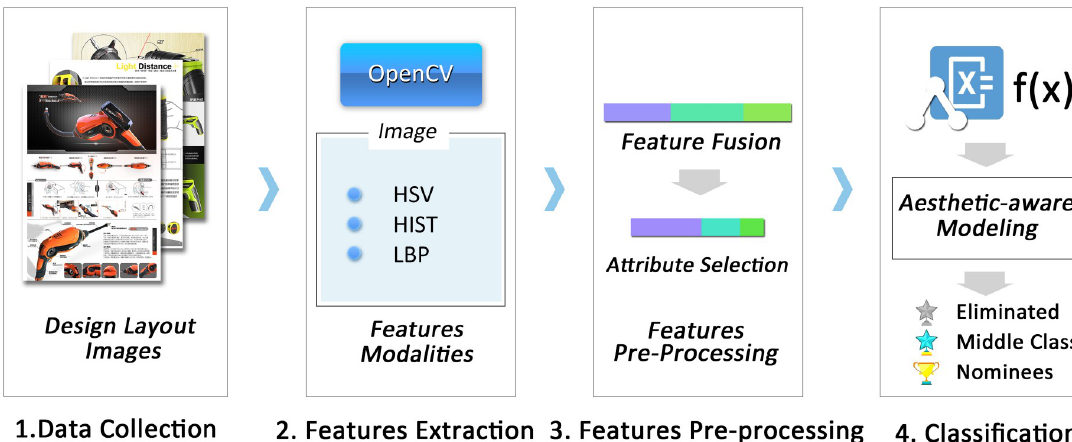
Fig 3. Experimental procedure for aesthetic-aware modeling, based on design awards